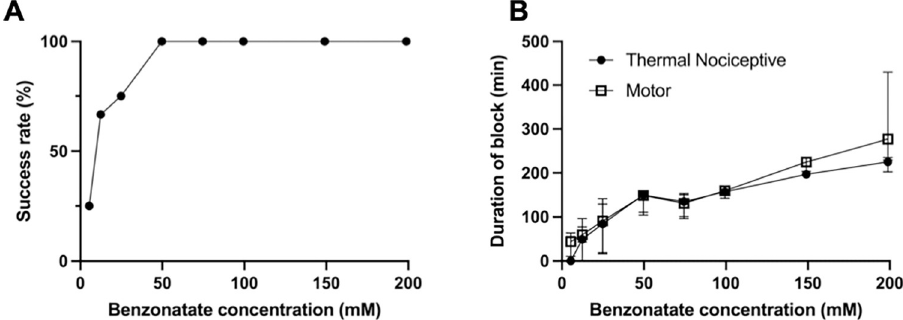
Fig 2. Effect of benzonatate concentration on nerve blockade. (A) Frequency of successful thermal nociceptive block with varying concentrations of benzonatate. n = 4 per group except n = 8 for 99.4 mM and n = 12 for 12.4 mM. (B) Duration of nerve blockade from benzonatate. Data are medians with 25 th and 75 th percentiles, n = 4 except n = 8 for 99.4mM and n = 12 for 12.4 mM. p > 0.05 for comparison of durations of sensory and motor block at each concentration by the Wilcoxon signed-rank